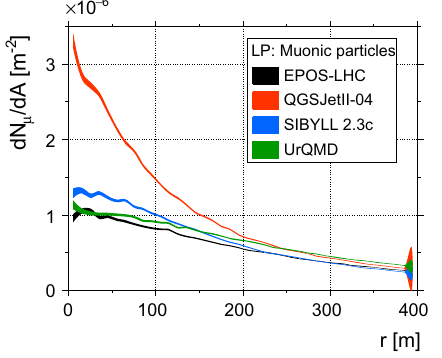
Fig. 3 Muon LDF contribution from events lead by muonic family particles muonic family will more likely affect the outcome at ground level. For the three high energy models, the largest ground level muon source originates from κ 3 events (highly inelas- tic interactions) while for UrQMD it is from κ 1 (diffractive interactions).